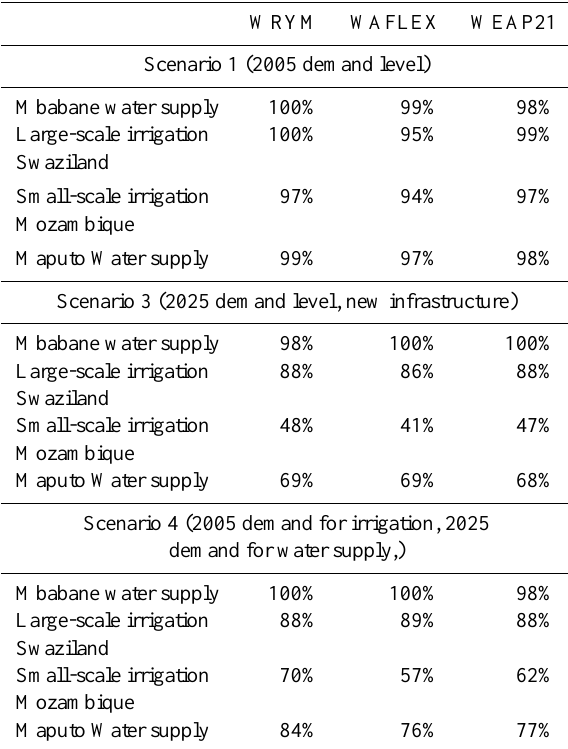
Table 7. Level of satisfaction for the main